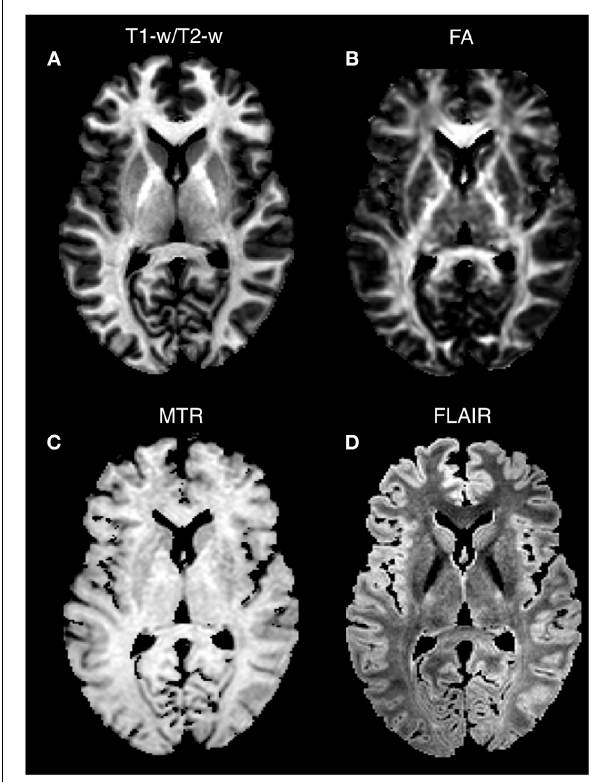
FIGURE 9 | Single-subject images: comparison between image modalities. T1-w/T2-w (A) , FA (B) , MTR (C) , and FLAIR (D) images for Subject 30 of the KIRBY database are shown in an axial section. Since conventional MRI images have arbitrary intensity scales, the four modalities are scaled according to the 1 and 99th percentiles. Note that higher intensity values in T1-w/T2-w, FA, and MTR characterize structures with a greater degree of myelination, whereas an inverted intensity scale defines the FLAIR